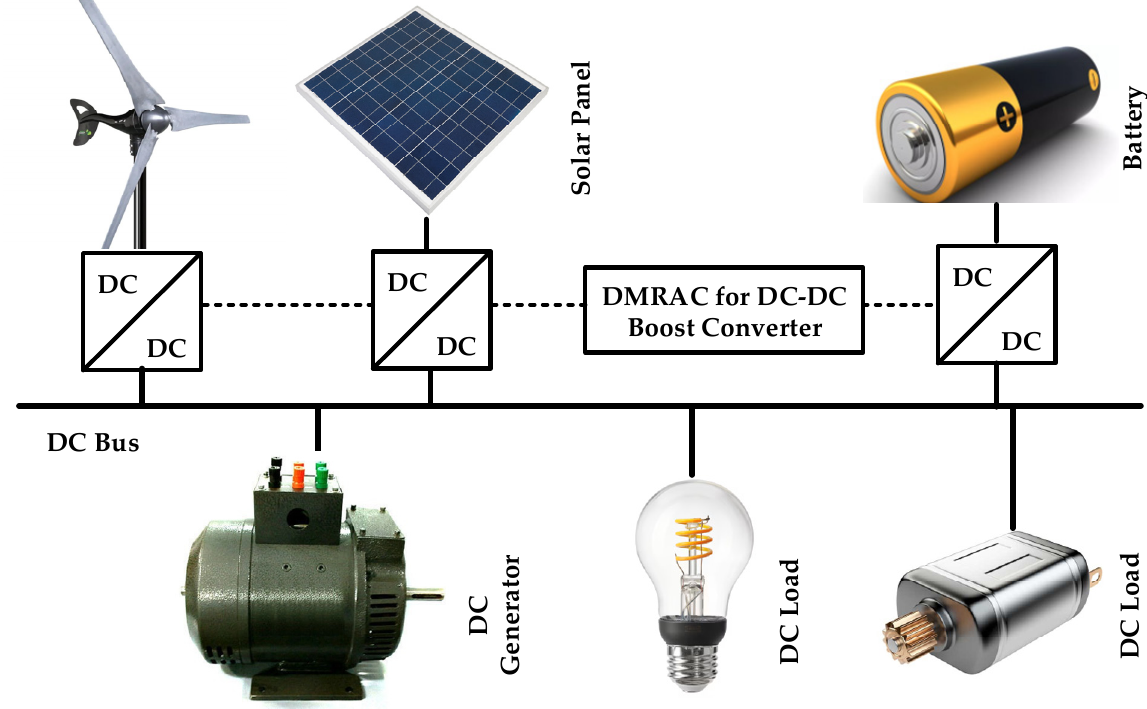
Figure 2. Isolated MG diagram .